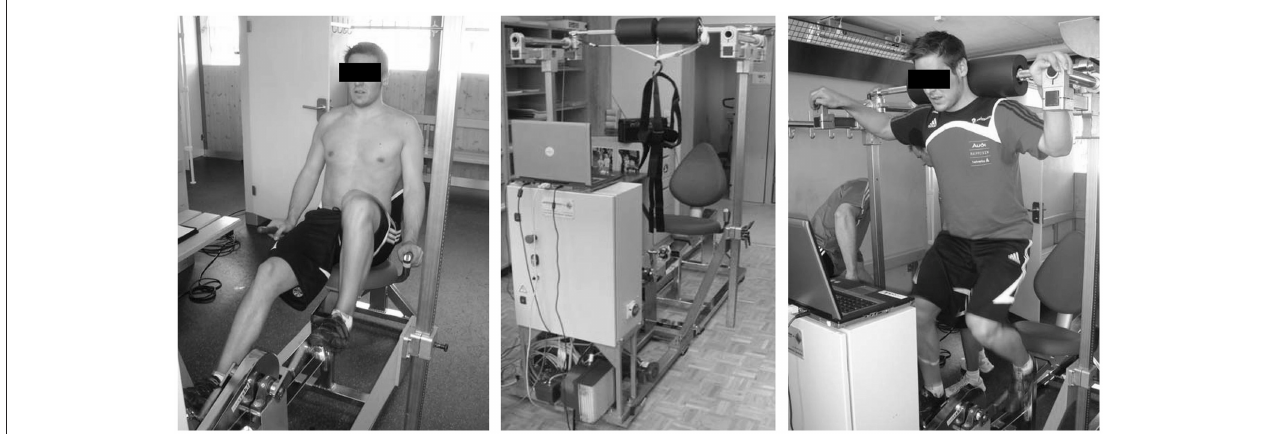
FIGURE 3 | Eccentric ergometer custom built for the Swiss National ski-team, capable of providing loads up to 2000W. As shown, this ergometer can be used in a sitting and in a standing position (with permission from Hoppeler, 2014).